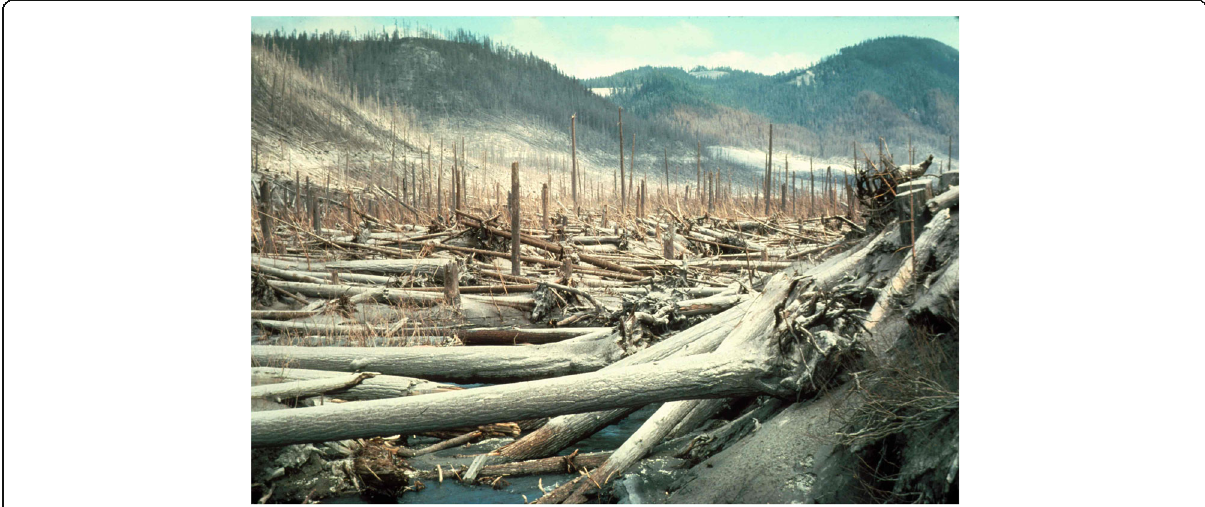
Fig. 3 The eruption of Mount St. Helens on May 18, 1980, left behind significant legacies of living and dead organic matter (including snags and logs), which were important elements in the development of the post-eruption ecosystems; this environment provided the stimulus for recognition of the concept of biological legacies of disturbances and a natural model for variable retention harvesting. Note that these legacies have both biological and physical influences on the post-disturbance